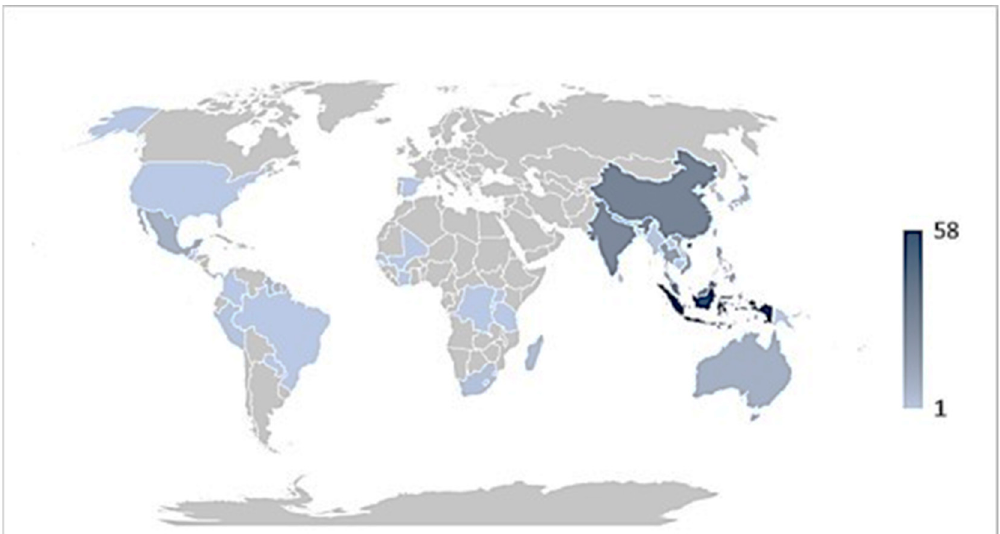
Figure 3. Density map showing a number of epiphytic medicinal plant species used by different countries. The number of species used is proportional to colour intensity.